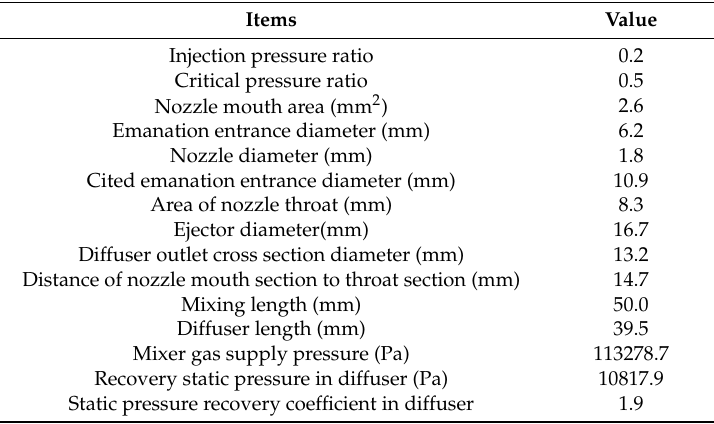
Figure 4. 3D model figure of mixer-ejector. Table 3. Specifications of the mixer-ejector.